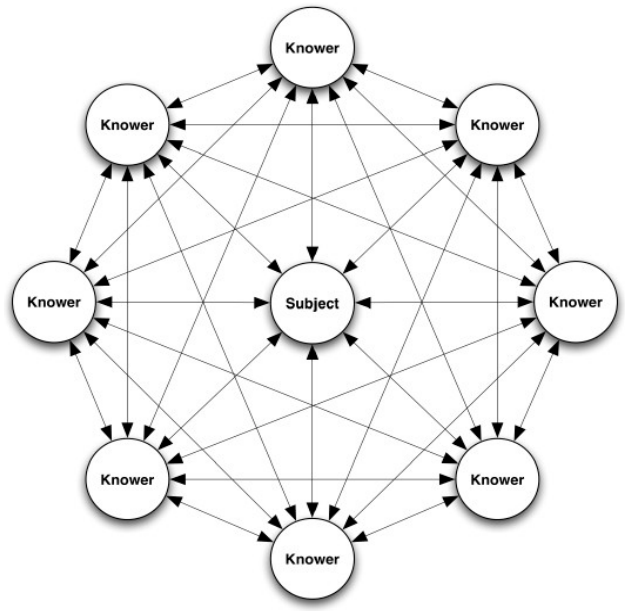
Figure 2. Parker Palmer’s Subject-Centered Pedagogy-A Community of